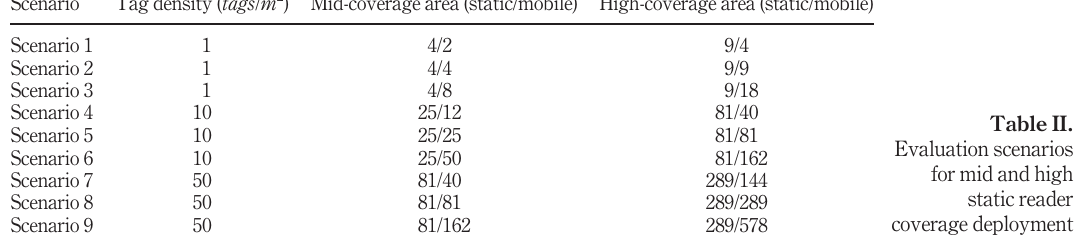
Table II. Evaluation